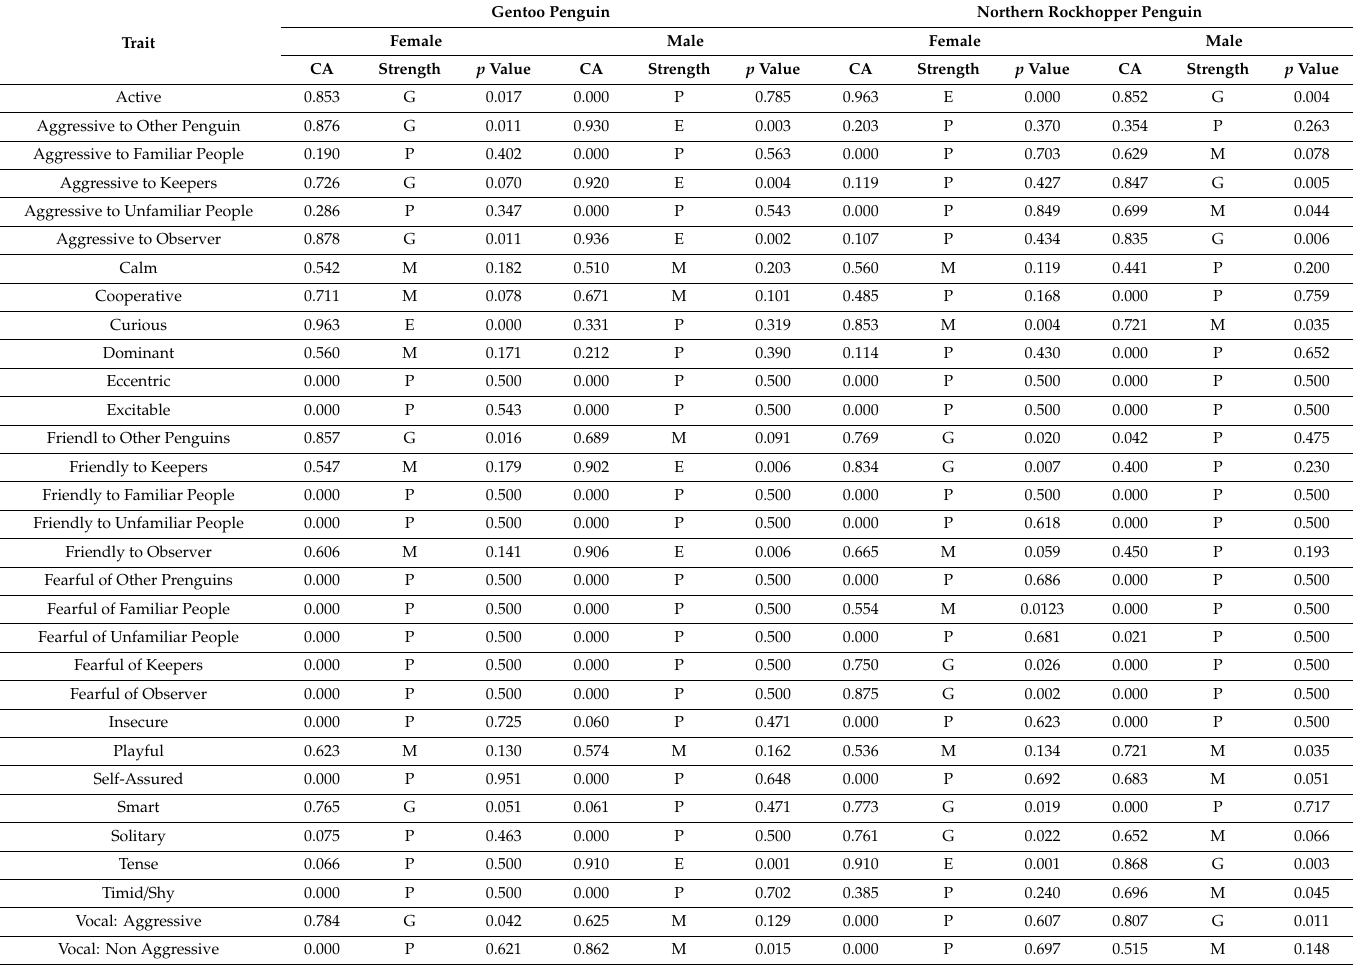
Table 2. The table comprises Cronbach’s alpha coe ffi cient values (CA), calculated separately for Gentoo and Northern Rockhopper, divided by gender. The coe ffi cients are classified as “poor” (P), “moderate” (M), “good” (G) and “excellent” (E), p < 0.05 values are considered as statistically di ff